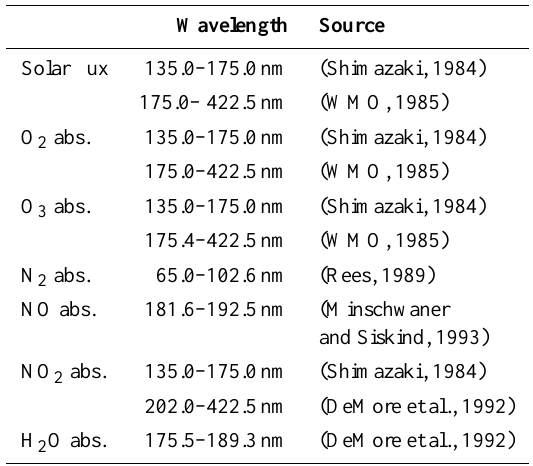
Table 4. The sources for the absorption cross sections/dissociation efficiencies and solar flux data Wavelength